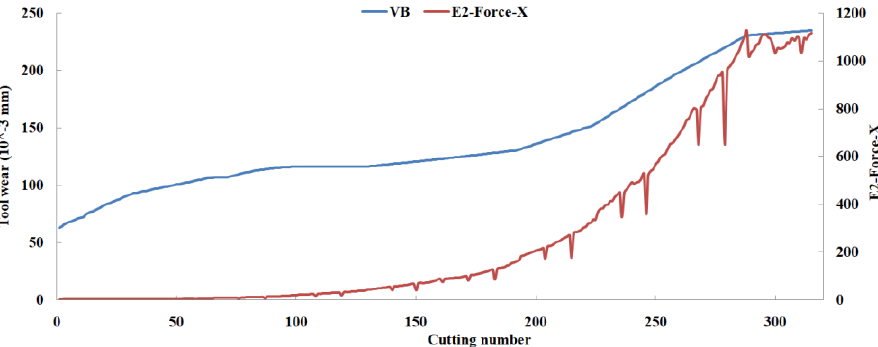
Figure 13. The scatter diagram between E 2 in X-dimension Force and tool wear value.